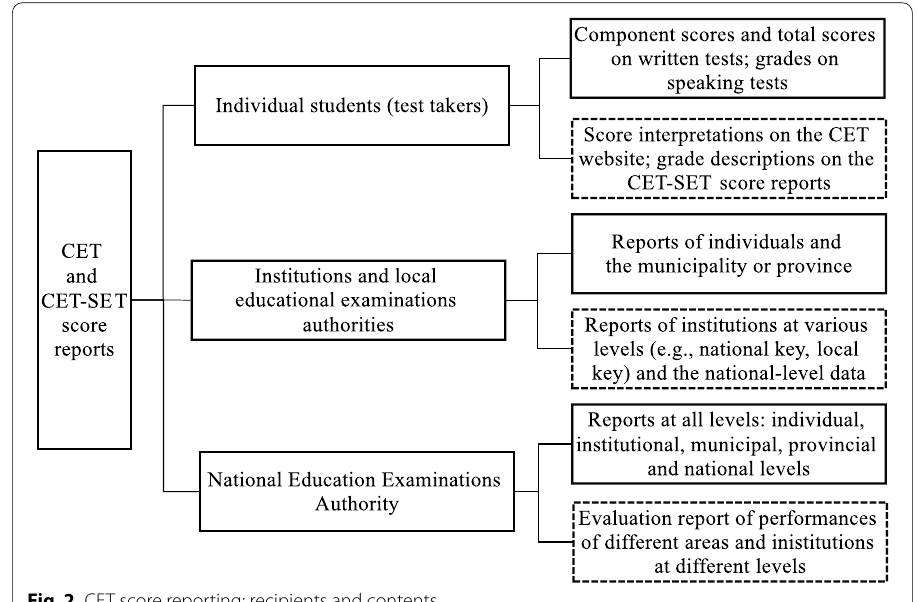
Fig. 2 CET score reporting: recipients and